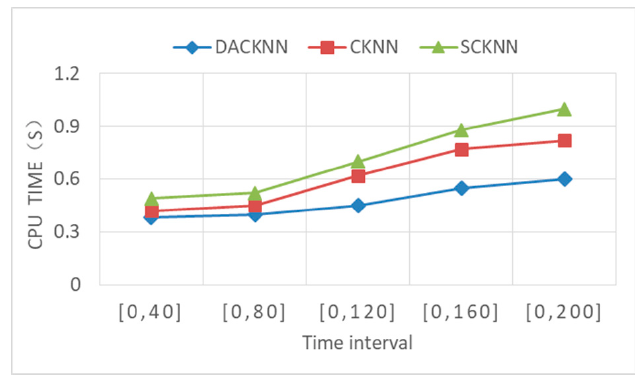
Figure 17. Time consumption of algorithms under different time intervals.